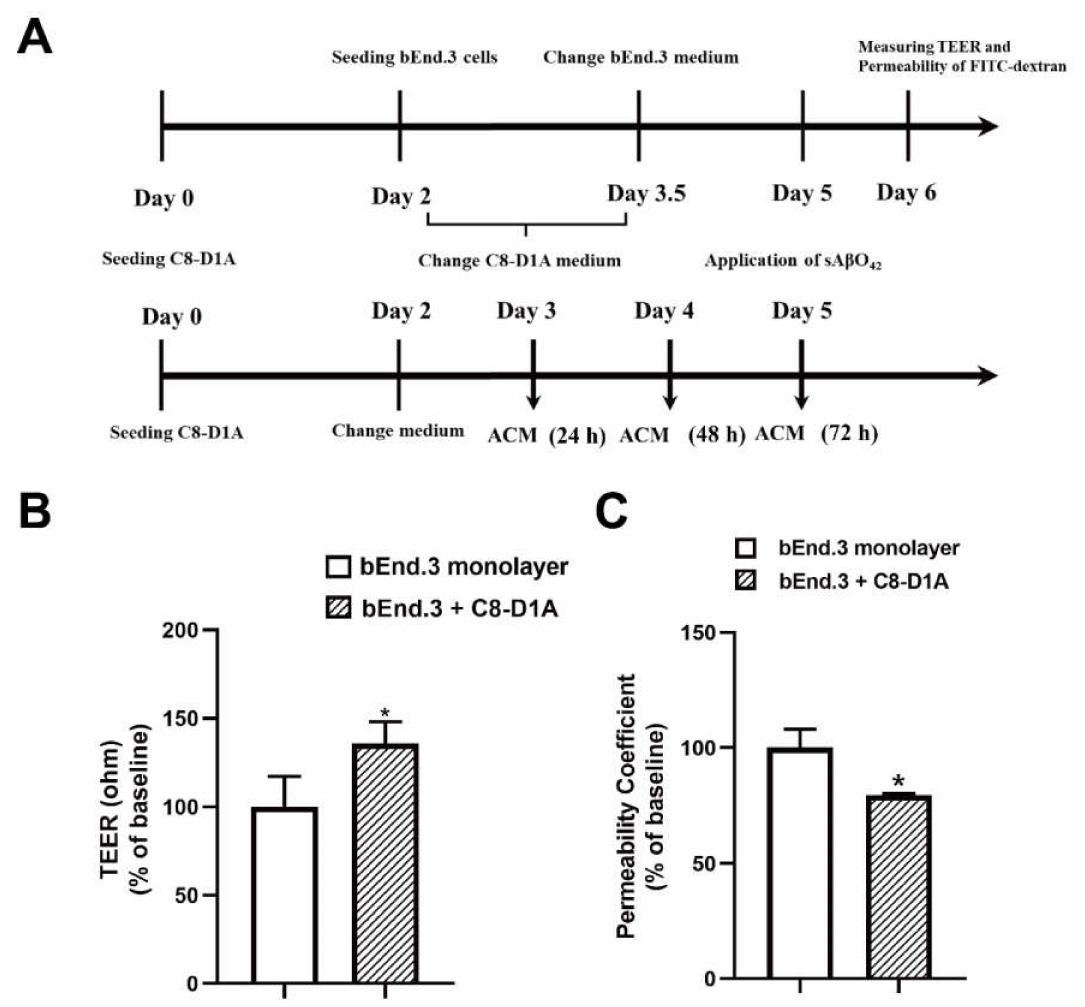
Figure 4. C8-D1A co-culture or astrocyte-conditioned medium (ACM) enhanced bEnd.3 endothelial barrier characteristics. ( A ) Schematic illustration of the preparation of the co-culture and ACM. The day when C8-D1A was defined was day zero (day 0). ( B ) TEER value and ( C ) permeability of FITC-dextran across the bEnd.3 monolayer and bilayer of co-culture system (C8-D1A + bEnd.3). Data are shown as means ± SD of at least three independent experiments and were analyzed by one-way ANOVA followed by a post hoc Dunnett’s test. * p ≤ 0.1 vs. control